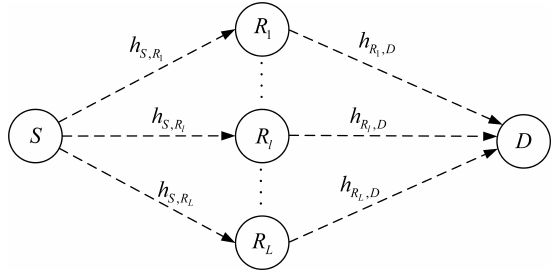
Figure 1. System model.